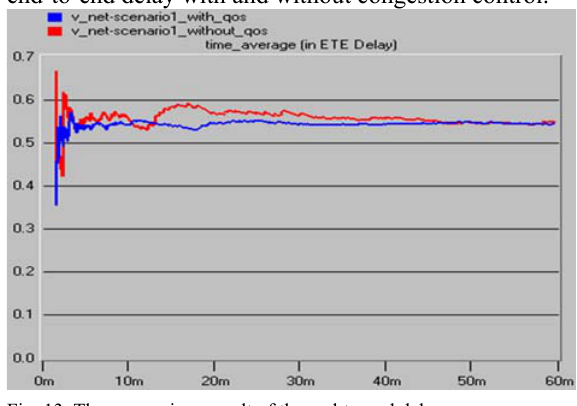
Fig. 13. The comparison result of the end-to-end delay It is seen that end-to-end delays both tend to balance after jitter period under t he two cases. The end-to-end delay eq uals about 0.55s under t he ca se o f